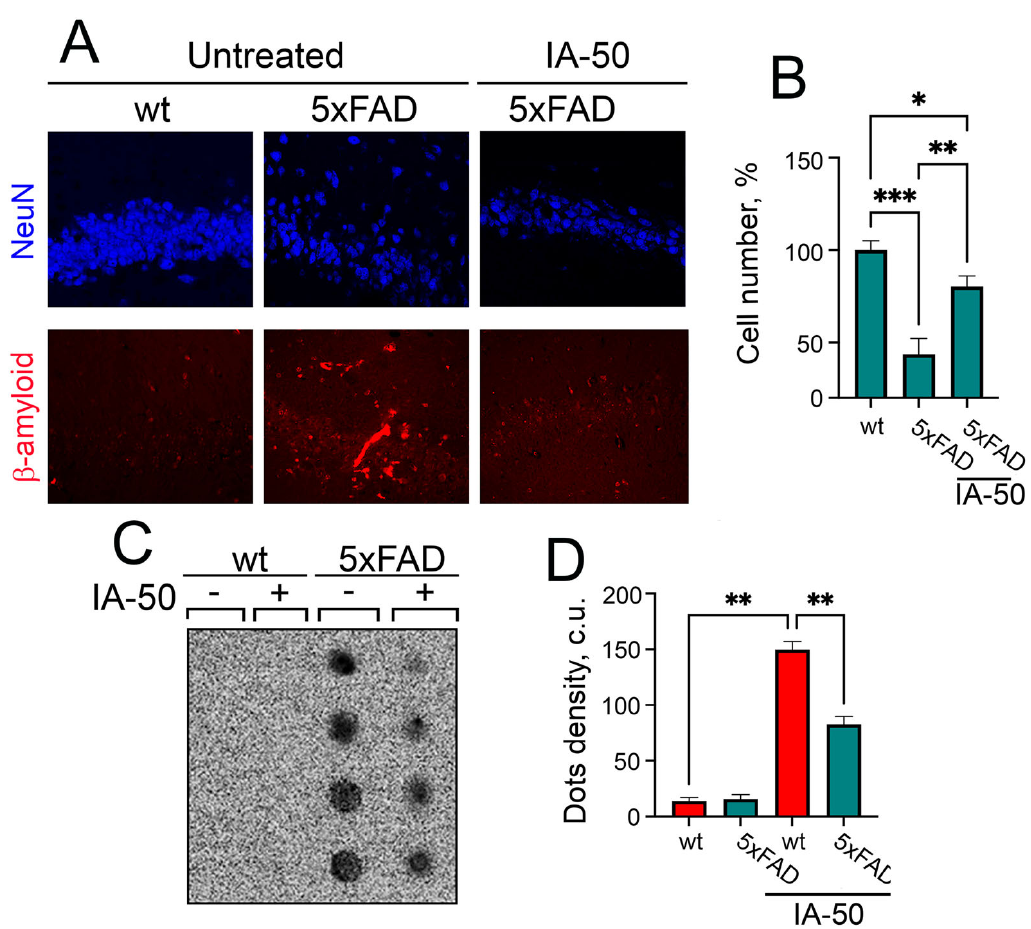
Figure 5. Histoimmunochemical and biochemical analysis of the hippocampi of the 5xFAD mice after therapy with IA ‐ 50 and treated mice. ( A ) Histoimmunochemical analysis of the hippocampi of the 5xFAD mice after IA ‐ 50 therapy. Slices were stained with anti ‐ NeuN antibodies (blue) or anti ‐ A β 1 ‐ 42 antibodies (red). ( B ) The number of neuron nuclei stained with anti ‐ NeuN antibodies was normalised to that in the hippocampus of untreated WT animals and presented as histogram bars. For each group, no less than 500 cells were counted. ( C ) Results of the A β 1 ‐ 42 aggregate amount analysis in the mouse hippocampus by ultrafiltration, followed by hybridisation with specific anti ‐ A β 1 ‐ 42 antibodies. Representative image is shown. ( D ) The result of the quantification of dot intensity obtained from the analysis of the amount of A β 1 ‐ 42. The values are presented in conventional units. The mean values ± standard deviation of the results of three independent experiments are shown; differences are significant at * p < 0.05,** p < 0.01 or *** p < 0.005.